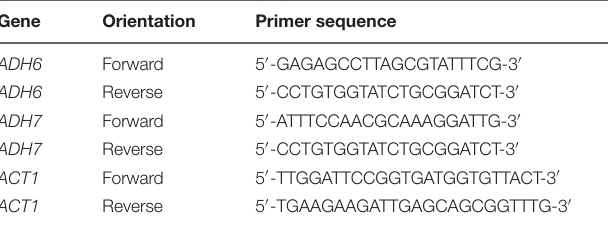
TABLE 2 | List of primer pairs used in quantitative real